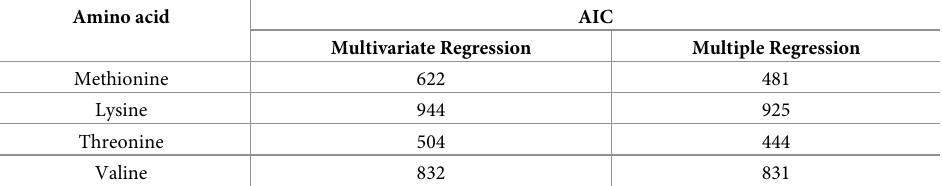
Table 2. Akaike information criteria (AIC) for multivariate regression and multiple linear regression models adjusted to different amino